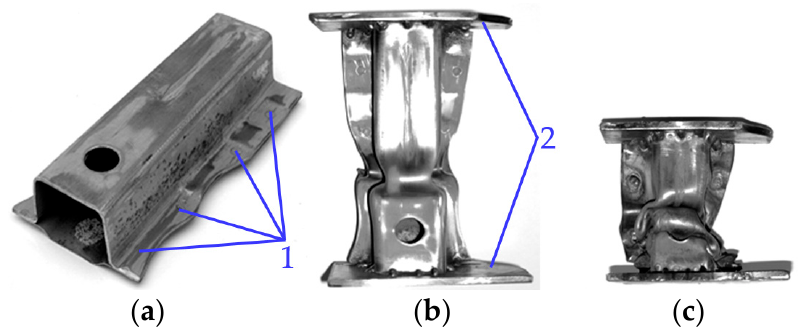
Figure 6. P1 specimen used for the experiment: before the test ( a ); after the first test ( b ); after the second test ( c ); (1—positions of the spot-welded joints; 2—fixing plates). The wall thickness of the parts was thk 1 = 1.4 mm and thk 2 = 0.7 mm. For accurate